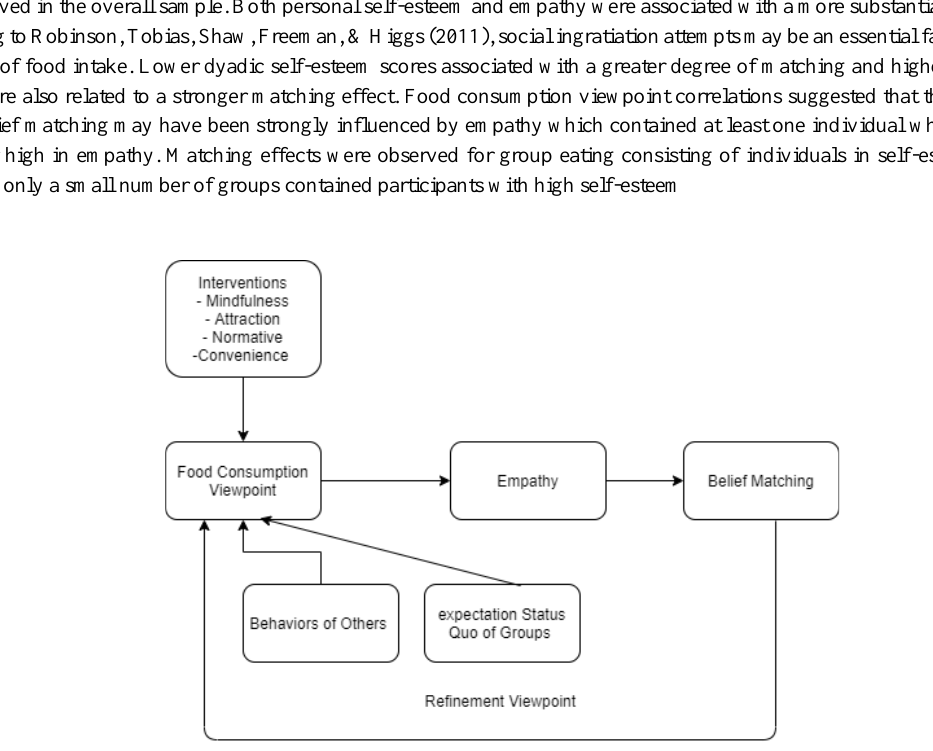
Figure 3 : Proposed Frameworks on Responsive Eating Behavior in Social Setting 1